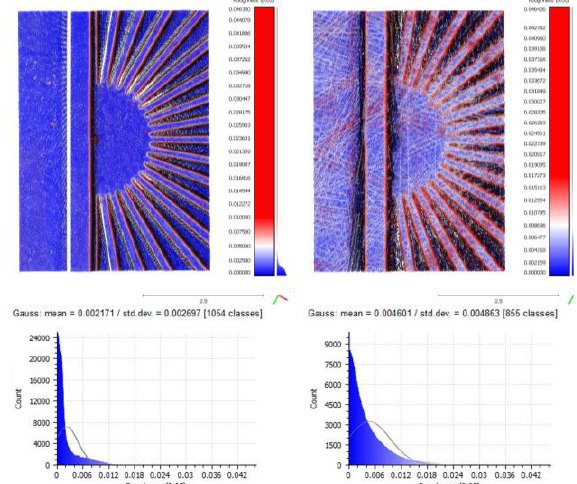
Figure 9. Upper part of the apse, roughness comparison between TLS (left) and MMS (right). The analysis has been performed using CC (di/V sphere r = 0.05